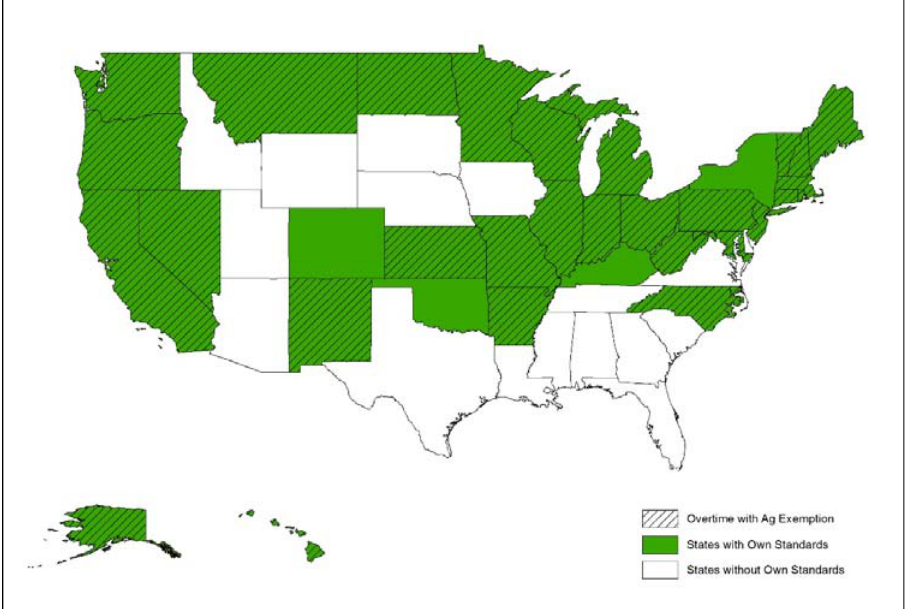
Figure 2. Overtime Agricultural Exceptions by State,